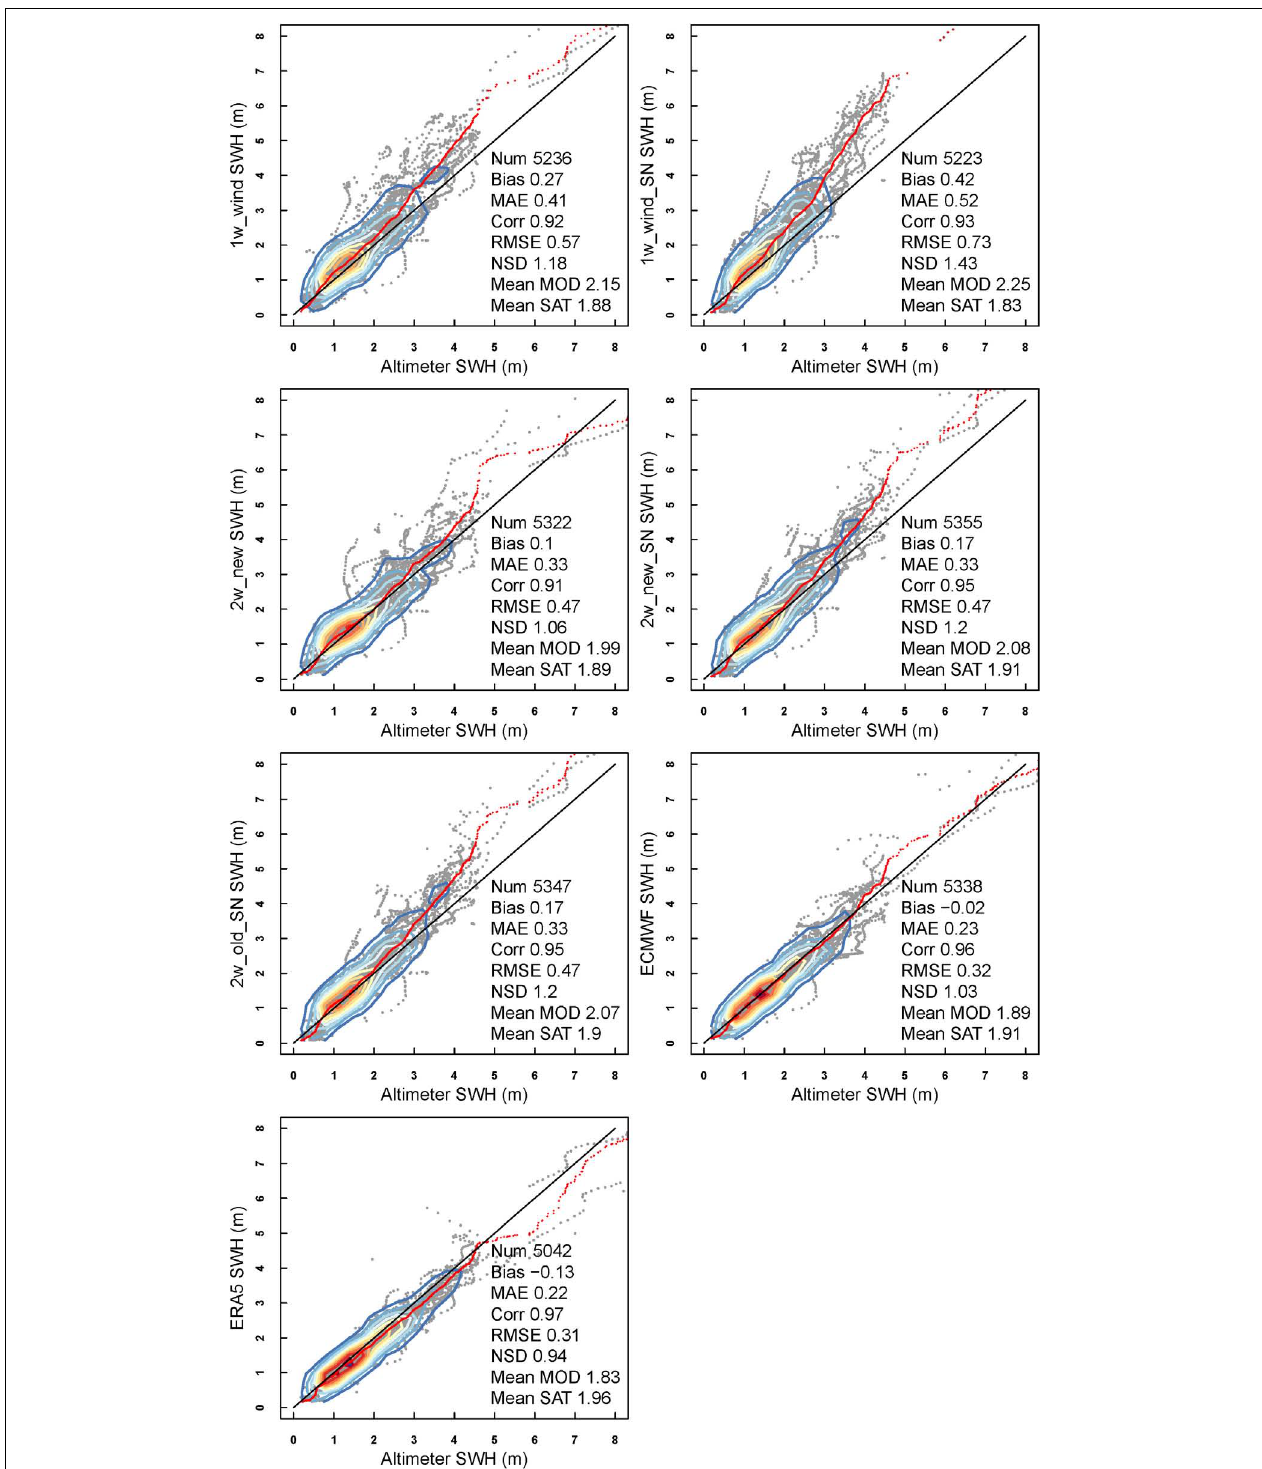
FIGURE 11 | Comparison of the modeled significant wave height ( y -axis) with satellite wave observations ( x -axis): qq plots (red dots) and scatter plots (gray dots). The kernel density estimations (contour lines) are included.